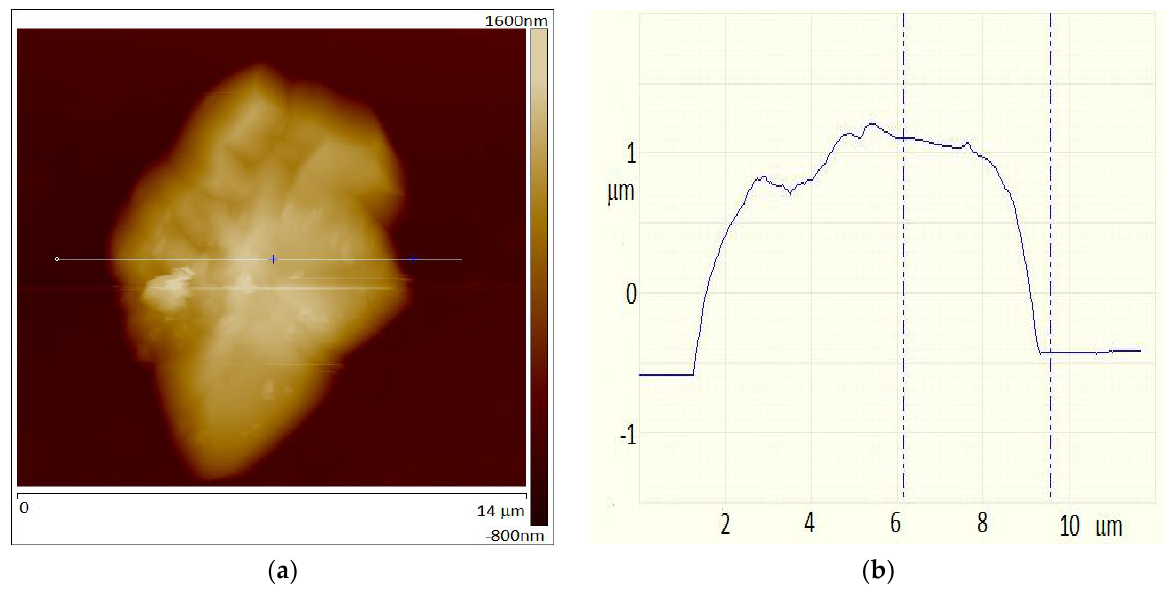
Figure 4. ( a ) AFM image of a blister on the surface of the Gr/Ge/Si(001) after 150 h of treatment in water vapor, ( b ) AFM scan of the blister.